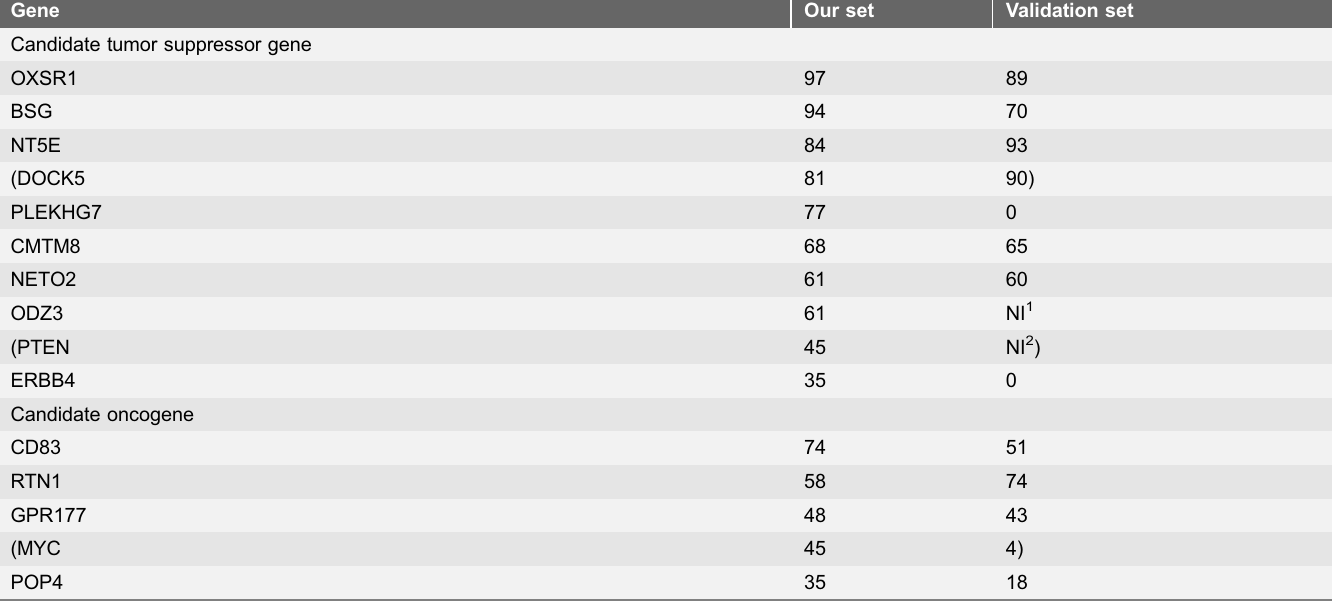
Frequency of involvement (percentage underexpression of a candidate tumorsuppressor gene and percentage overexpression of a candidate oncogene) in the original and validation set Known tumor suppressor genes ( DOCK5 , PTEN ) and oncogene ( MYC ) between brackets 1 No information. Applied probe does not recognize ODZ3 in